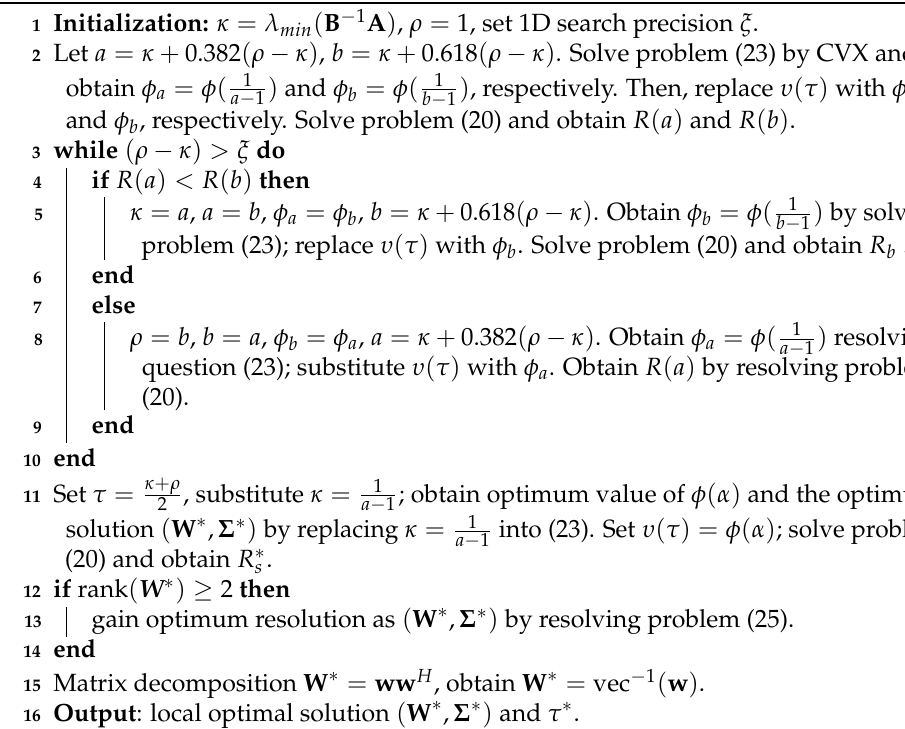
Algorithm 1: Algorithm proposed for solving problem